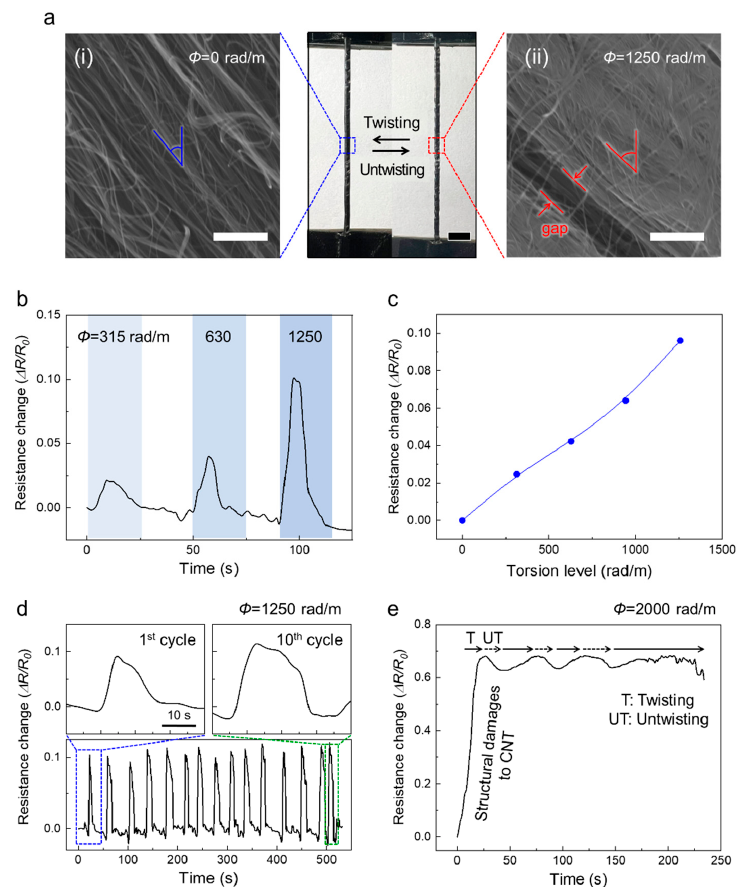
Figure 4. Electrical performances and morphological changes of CNT-wrapped core/sheath fiber strain sensor during torsional deformation. ( a ) Photographs of CNT-wrapped core/sheath fiber strain sensors with nonzero wrapping angle ( θ = 60 ° ) before and after applying torsional deformation of 1500 rad/m. Magnified SEM images of ( i ) well-aligned CNT bundles of fiber sensor in the pristine state and ( ii ) damaged CNT bundles after applying torsional deformation. ( b ) Change in the resistance of fiber sensors under various levels of torsional deformations (315, 630, and 1250 rad/m). Resistance changes ( c ) versus torsional strains from 0 to 1250 rad/m and ( d ) during 10 cycles of torsion deformations of 1250 rad/m. Magnified graphs showing the resistance changes in the 1st and 10th cycles. ( e ) Irreversible changes in the resistance of the fiber sensor under excessive torsional deformation. The CNT sheet undergoes permanent structural damage during